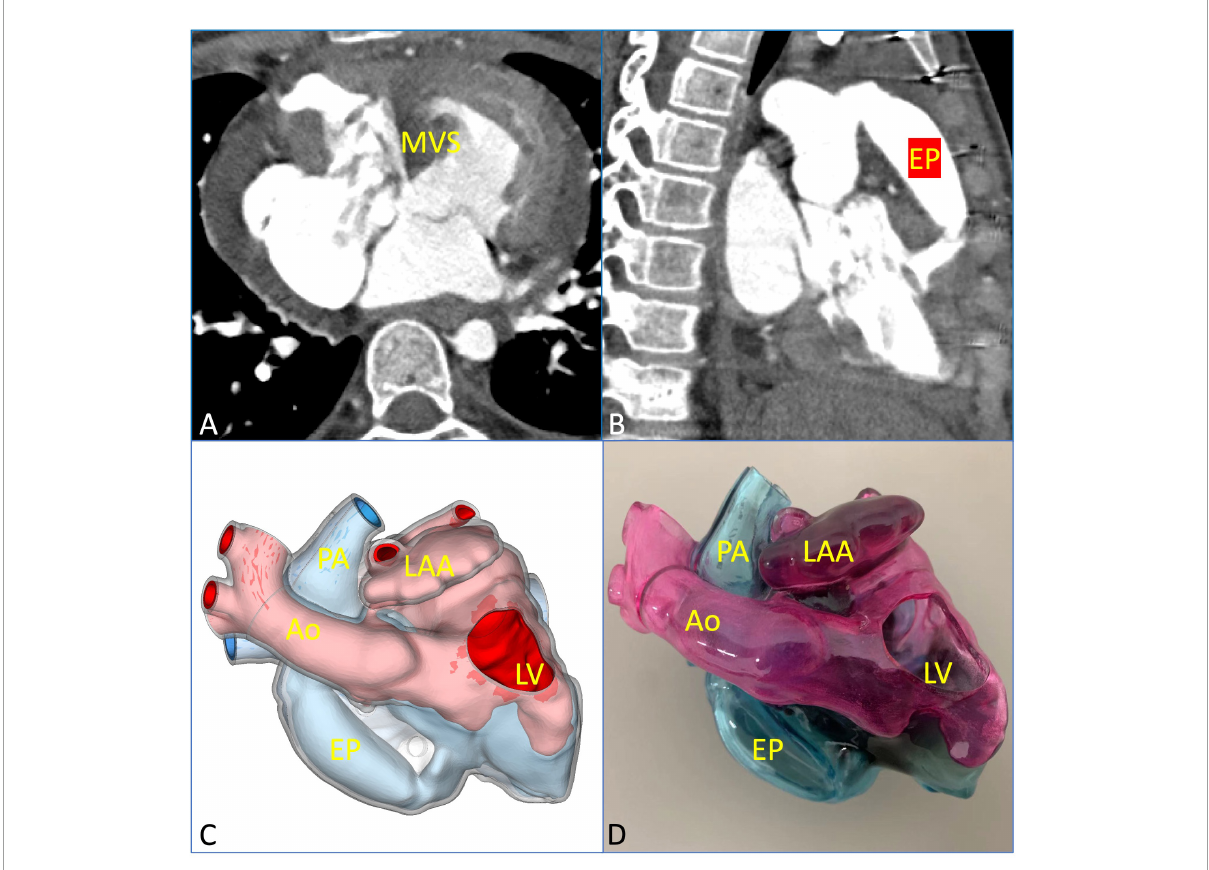
FIGURE4 Postoperative evaluation using multimodal imaging verified the curative effect of the surgical repair. (A) The residual membranous part of the interventricular septum was in a good position and well-functioning. (B) The extracardiac pipe functioned well. (C,D) The postoperative 3D printed model was observed clearly to verify the effect of the operation. EP, extracardiac